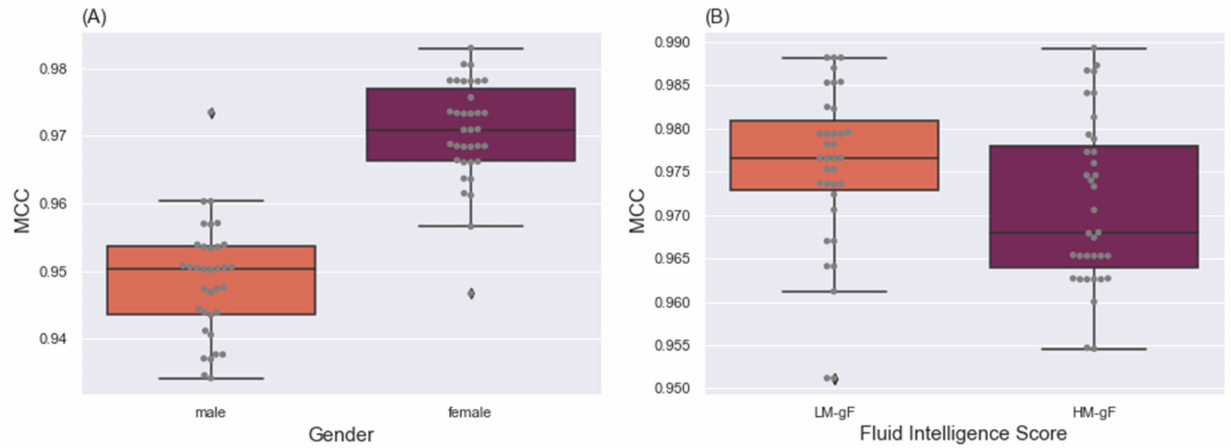
Figure 5. Box plots of the classification performance of the GCN model in 35 independent runs, by using gender sub-datasets ( A ) and fluid intelligence sub-datasets ( B ). Significant differences in classification performance of task fMRI data were observed between female and male data, but not between high and low fluid intelligence